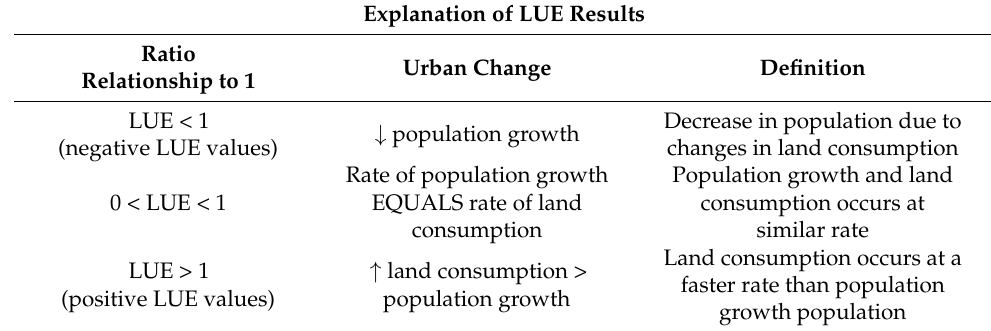
Figure 4. Built-up Area and Population for Denpasar, Kharkiv, and Mekelle. Source: Global Human Settlement layers— Population: GHSL-pop; Built-up Area: GHSL-built, 2018. Table 3. Land Use Efficiency (LUE) ratio